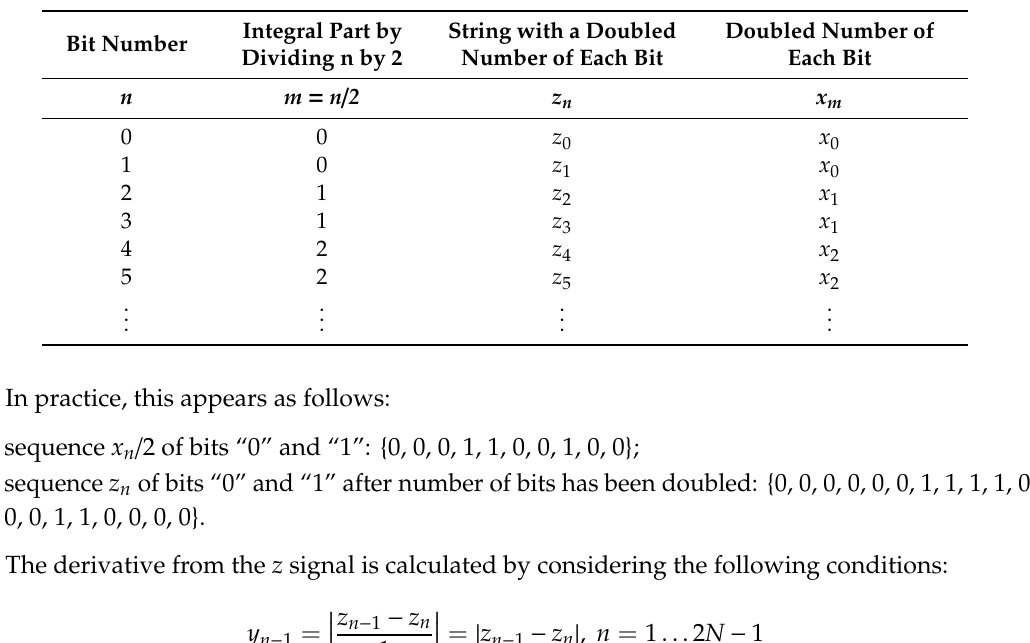
Table 2. An algorithm of doubled number of